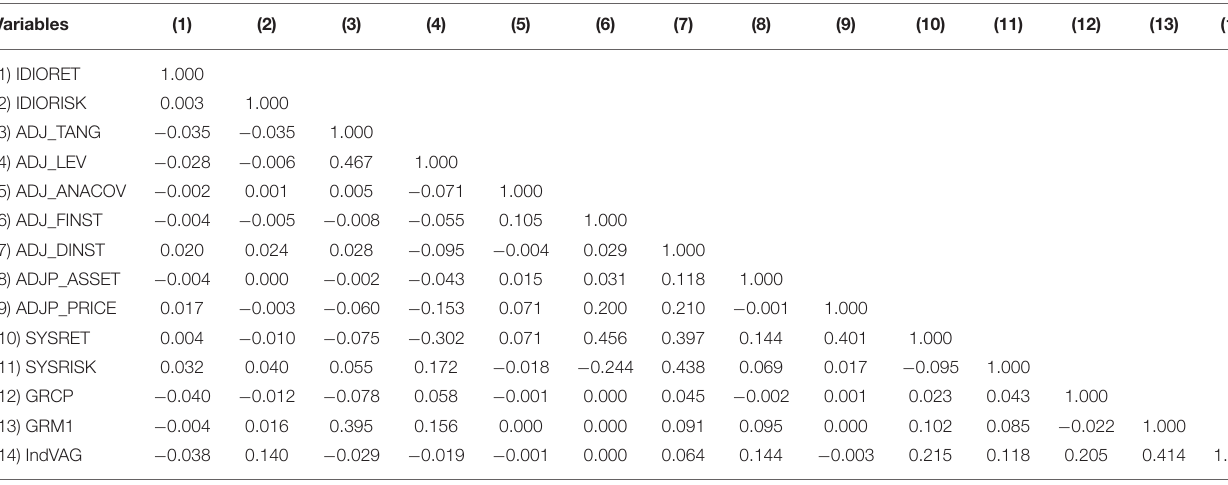
TABLE 2 | Pairwise correlations among independent